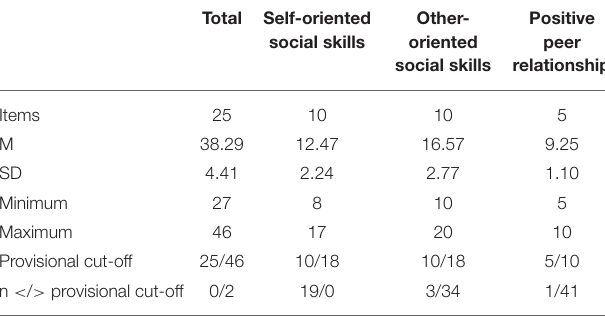
TABLE 4 | Descriptive statistics of SOCOMP-results ( n = 76).